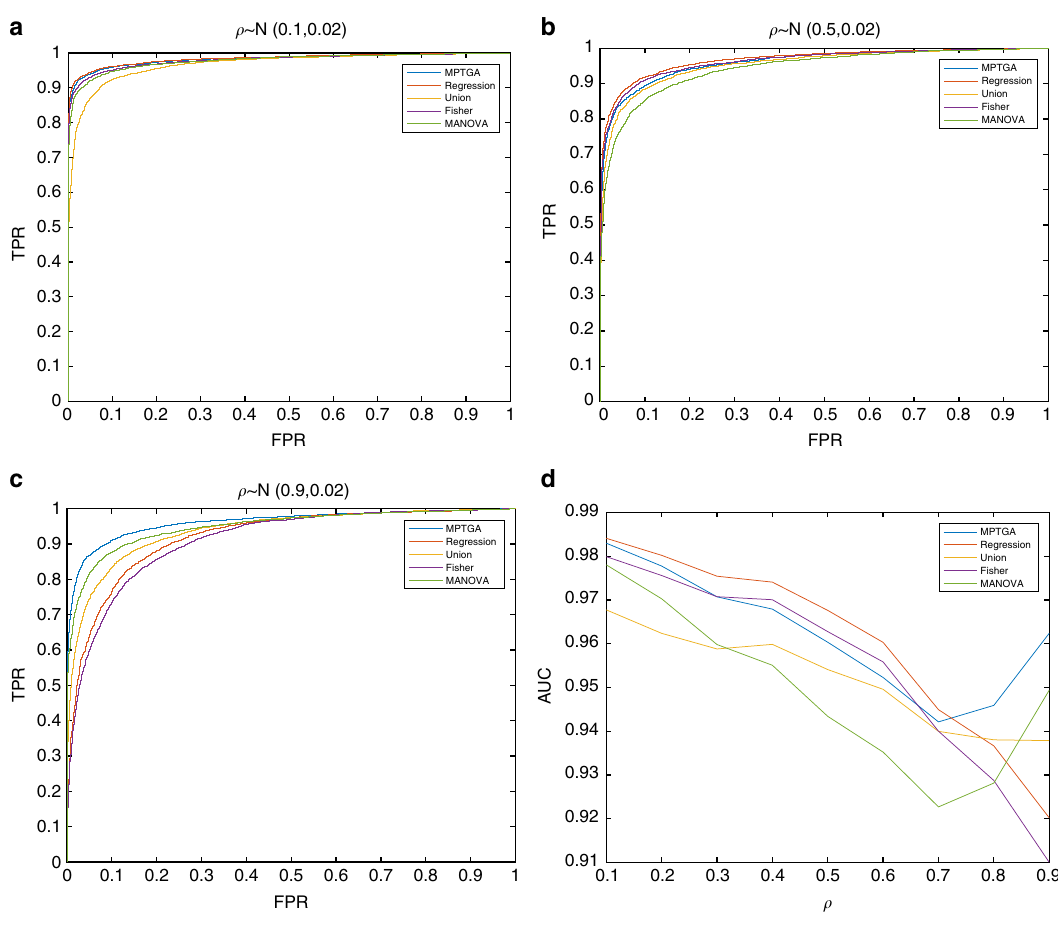
Fig. 2 Performance comparison among different time-dependent genetic association methods. Performance was assessed under different strength of inter time point correlation (auto-correlation) based simulated data. a ROC curves of different methods when auto-correlation is low; b ROC curves of different methods when auto-correlation is intermediate; c ROC curves of different methods when auto-correlation is strong; d area under the curve (AUC) of different methods under different strength of